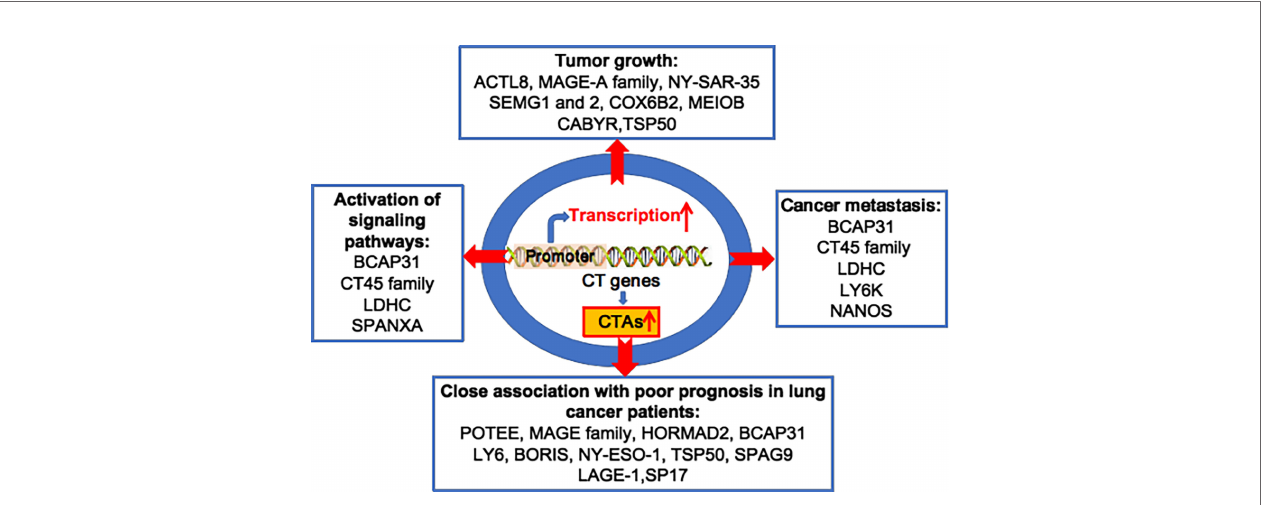
FIGURE 1 | Oncogenic CTAs drive lung cancer initiation and progression. Various CT genes are aberrantly activated, and overexpression of CTAs plays important roles in lung tumour growth, cancer metastasis, activation of multiple signalling pathways, and is closely associated to poor prognosis in lung cancer